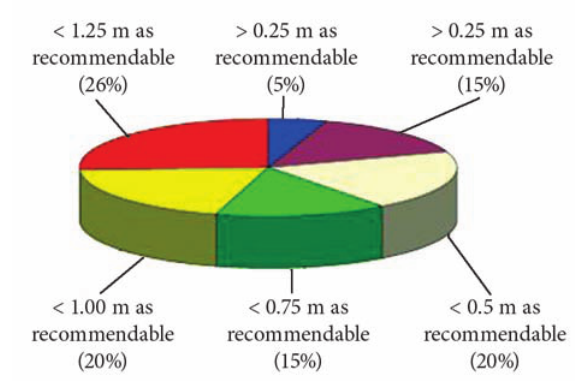
Fig. 5. Distribution of roundabouts by the carriageway width